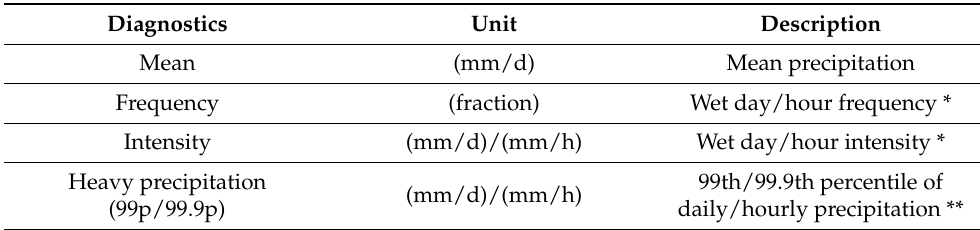
Table 2. Statistical indicators used in this study where (*) indicates that a wet day (hour) is a day (hour) with precipitation ≥ 1 mm ( ≥ 0.1 mm) and (**) indicates that percentiles are calculated using all events (wet and dry) following